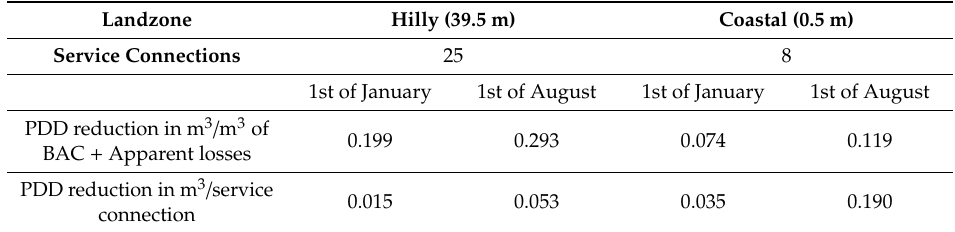
Figure 20. Comparative diagram of estimated leakage per billing period before and after the modeling application of the theoretical PM scheme for 2016 (left) and bar graph of the corresponding percentage decrease for each billing period (right). Table 7. Pressure-driven demand (PDD) reduction for two indicative landzones expressed in m 3 per m 3 of BAC + apparent losses and in m 3 per service connection.